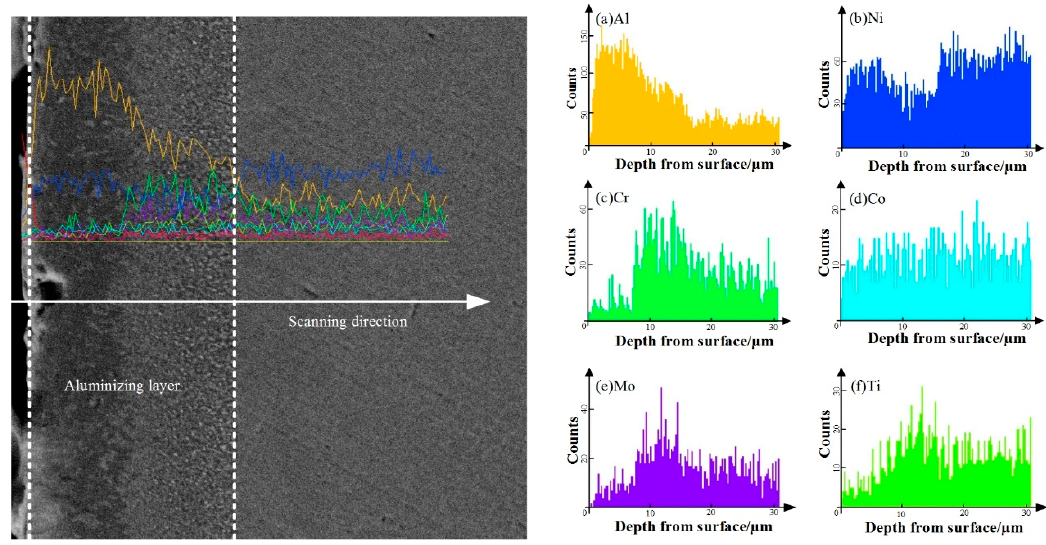
Figure 2. Scanning electron microscopy (SEM) morphology and distribution of the main elements.